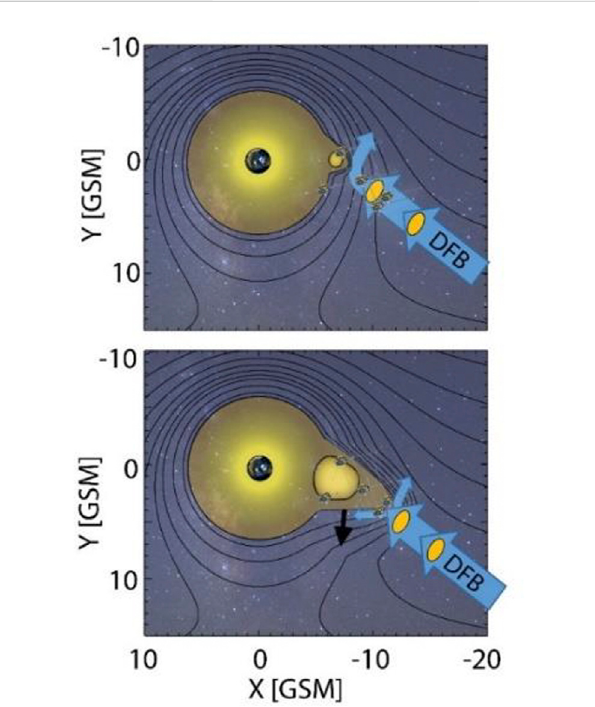
FIGURE 1 Modi fi ed from Gabrielse et al., 2019a. Illustration of mesoscale messengers of magnetic fl ux (DFBs) & particle fl ux (injections) as building blocks of the global dipolarization/injection.